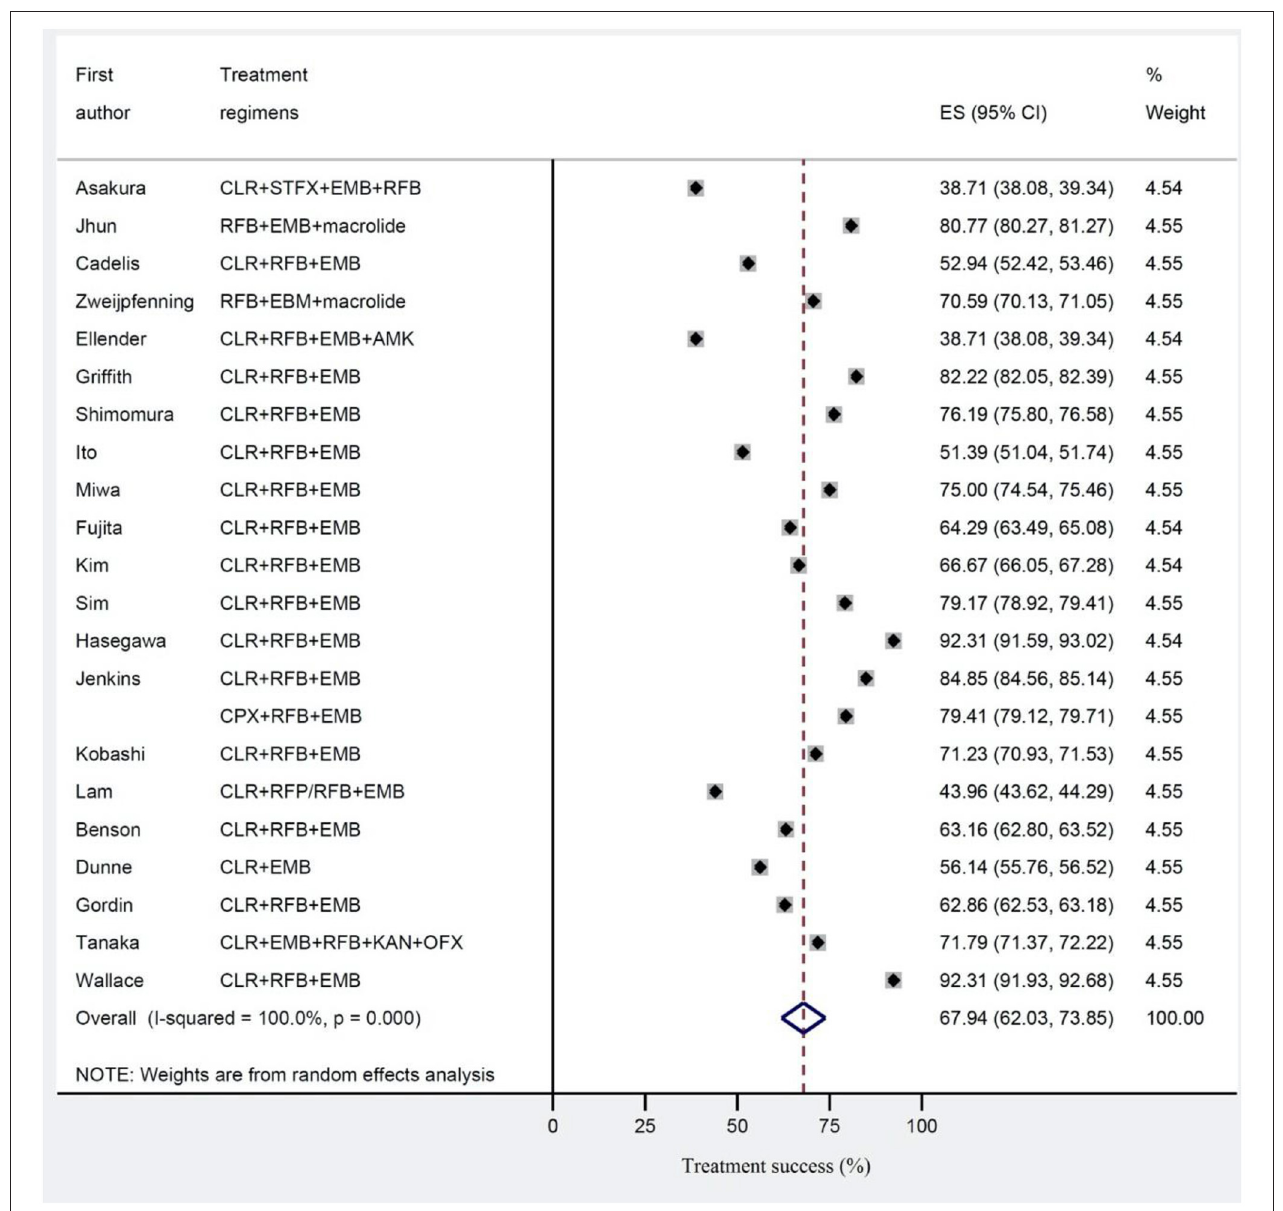
FIGURE 3 | Treatment success for Mycobacterium avium complex (MAC) disease in studies without clofazimine in their regimen.